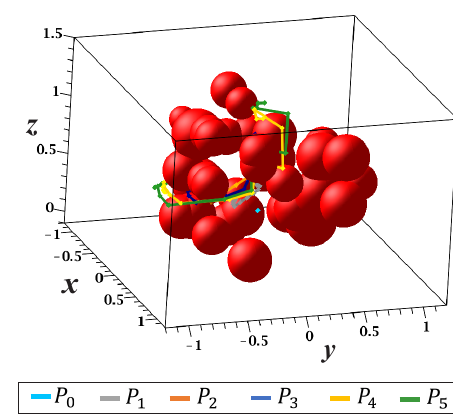
( b ) Joint-points paths visualization (query 1, view 2).